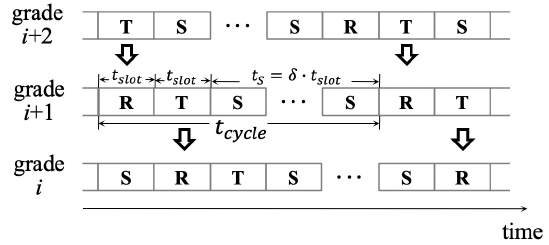
Figure 2. Illustration for pipelined scheduling along a packet forwarding path from grade ( i + 2 ) ( i ∈ N and i > 1) to grade i